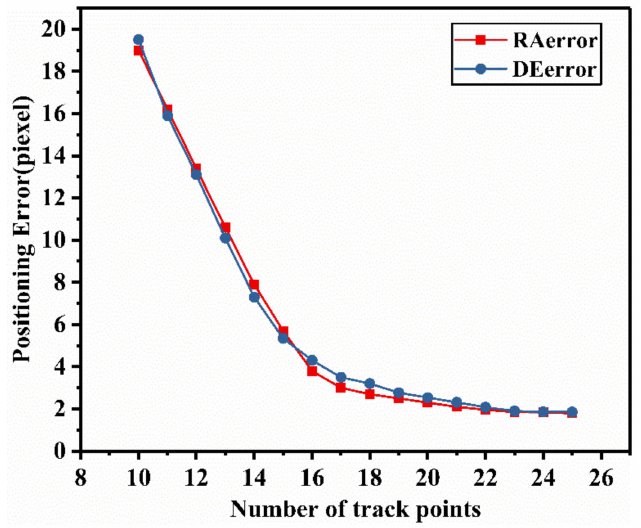
Figure 8. Influence analysis for the number of track points on the positioning